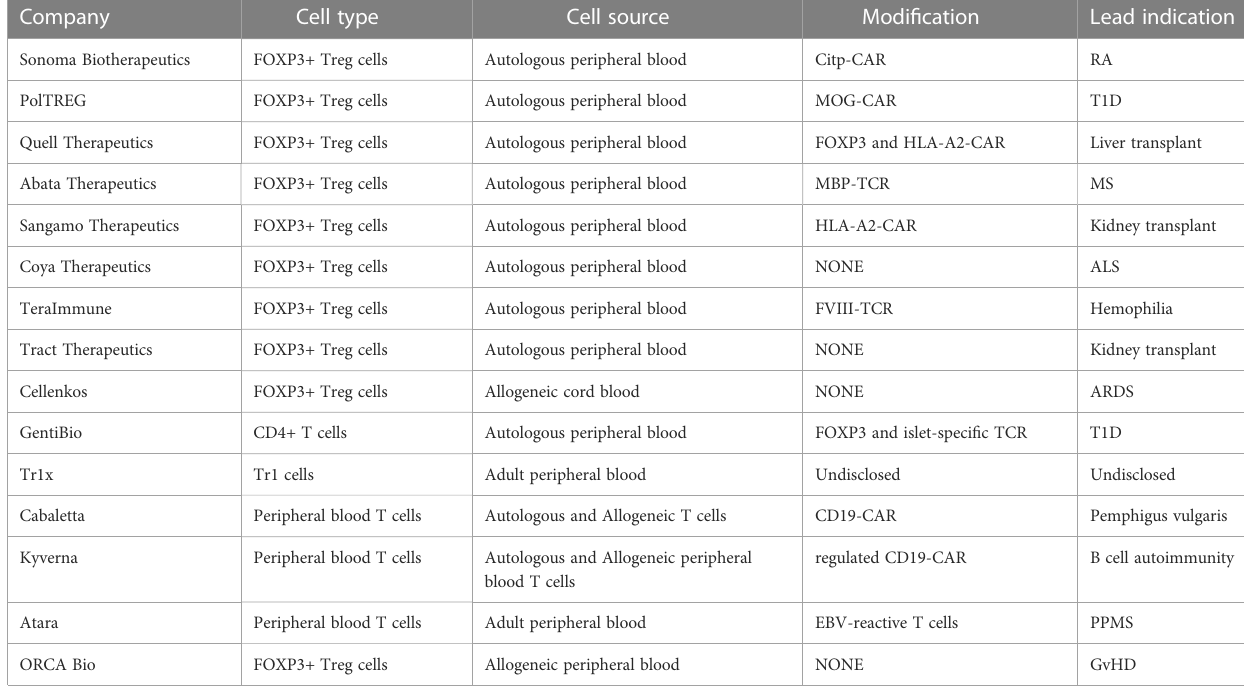
TABLE 1 Companies involved in regulatory cell adoptive immunotherapy.